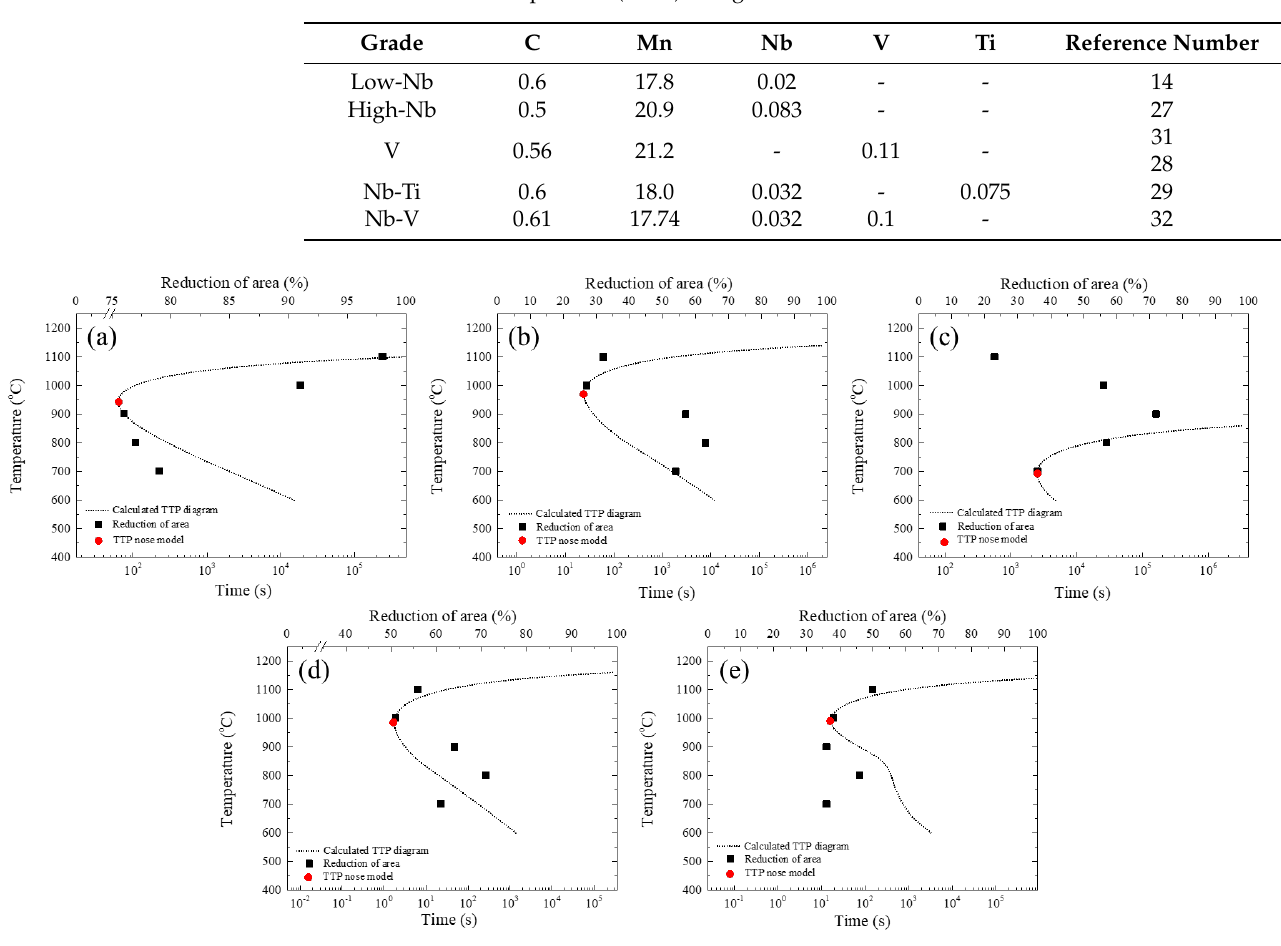
Table 2. Chemical composition (wt.%) of high-Mn steels from reference data.